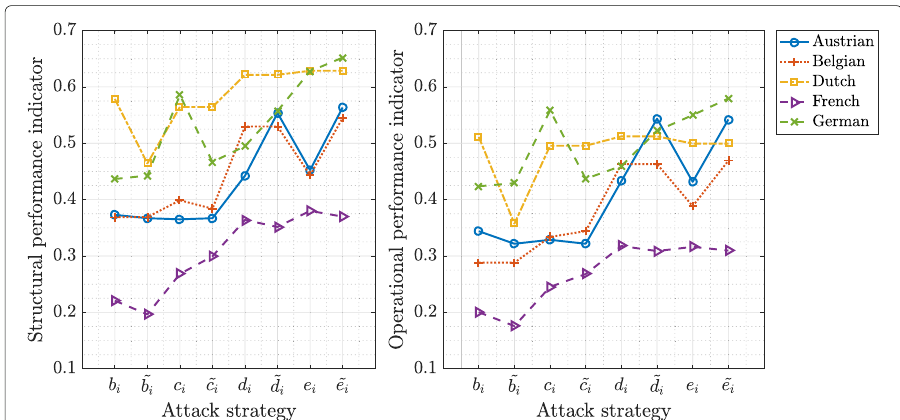
European power grids after the targeted